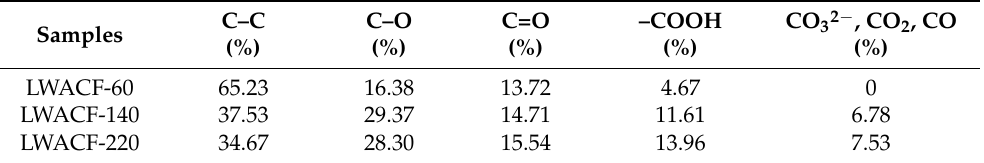
Table 2. Relative surface concentrations of carbon species obtained by fitting the C1s XPS spectra for LWACFs with different activation times at 800 ◦